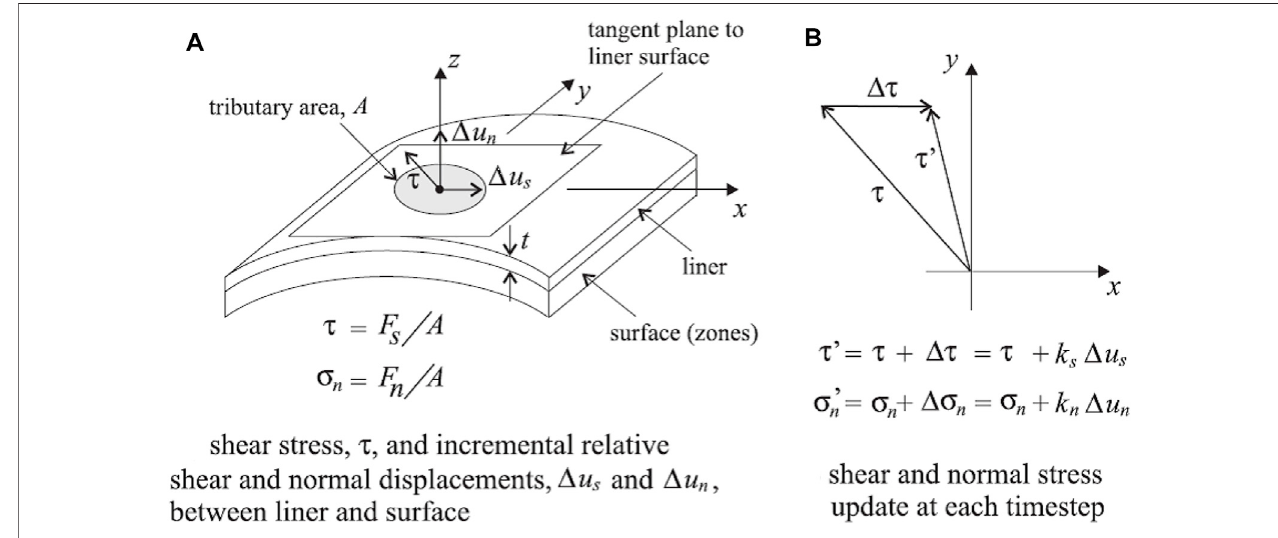
FIGURE 4 | Idealization of interface behavior at a liner node. (A) Liner and surface. (B) Shear and normal stress (Itasca, 2005).